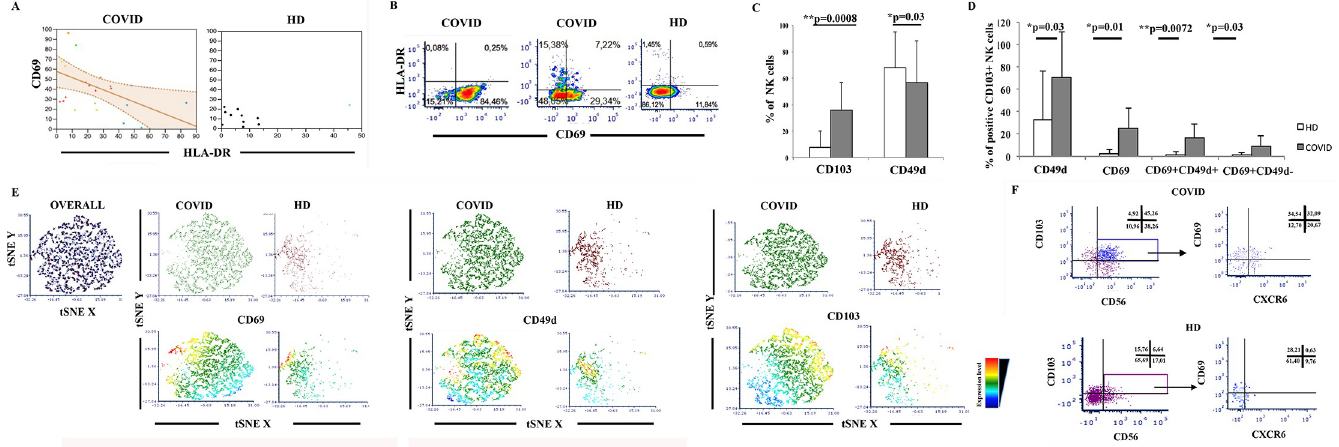
Fig 3. Flow cytometric and correlation analysis of the expression of activation and tissue-residency molecules on circulating NK cells in COVID-19 patients. Panel A: Correlation analysis of the expression of CD69 and of HLA-DR on PB CD56+CD16+ NK cells according to least squares linear regression. Slope and 95% confidence limits are plotted. p = 0.01. Panel B: Flow cytometric dot plot analysis of the expression of CD69 and of HLA-DR on circulating NK cells in different patients. CD69 and HLADR are mostly not coexpressed in COVID-19 patients. A representative HD profile is also shown. Panel C: Analysis of CD103 and of CD49d expression on PB NK cells in COVID-19 patients and HD. Histograms show mean ± SD. Significant differences are indicated according to the Mann-Whitney U-test. Panel D: Increased coexpression of CD49d and CD69 in circulating CD103+ NK cells in COVID-19 patients. Histograms show mean ± SD. Mann-Whitney U-test analysis is shown. Panel E: A tSNE plot showing distinct expression of CD69, CD49d, and CD103 in COVID-19 and HD. Panel E: A t-SNE representation of the coexpression of CD69, CD103, CD49d in PB NK cells. Panel F: Analysis of CXCR6 expression on PB NK cells in a representative sample of COVID-19 patients and HD. Dot plots show CD103 expression on CD3-CD14-CD19- NK cells and their coexpression of CD69 and/or CXCR6. The proportion of positive cells is indicated. COVID- 19 patients have relevant circulation of CXCR6+CD69+CD103+NK cells, while HD have no such circulation (here 32.09% vs. 0.63%).